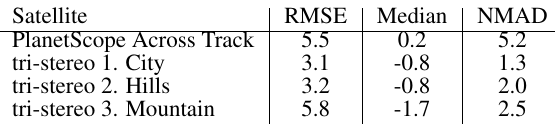
Figure 5. DSM generated from 100 stereo pairs of PlanetScope imagery over the test areas in Catalonia.